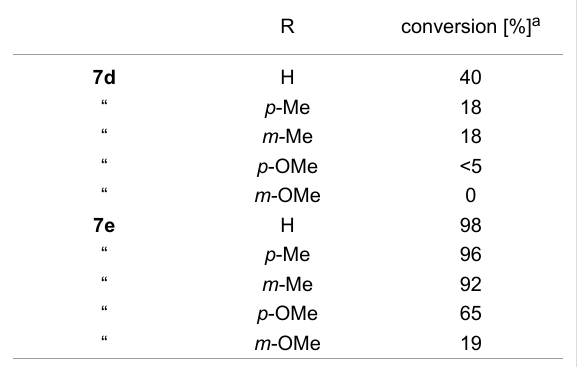
Table 4: Photocycloadditions of 7d and 7e with aromatic